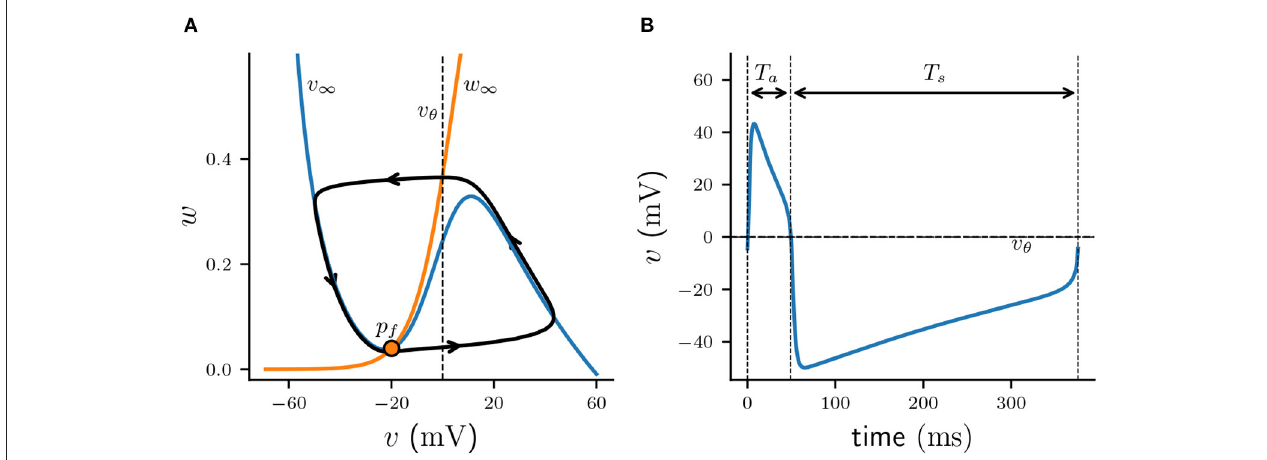
FIGURE 1 | Periodic solution of ML model neuron. (A) Projection of limit cycle onto ( v , w )-phase plane with v -nullcline (blue, v ∞ ) and w -nullcline (orange, w ∞ ). Unstable fixed point p f is indicated by an orange dot; firing threshold v θ is denoted by a dashed line. (B) Corresponding voltage trace v ( t ) of an action